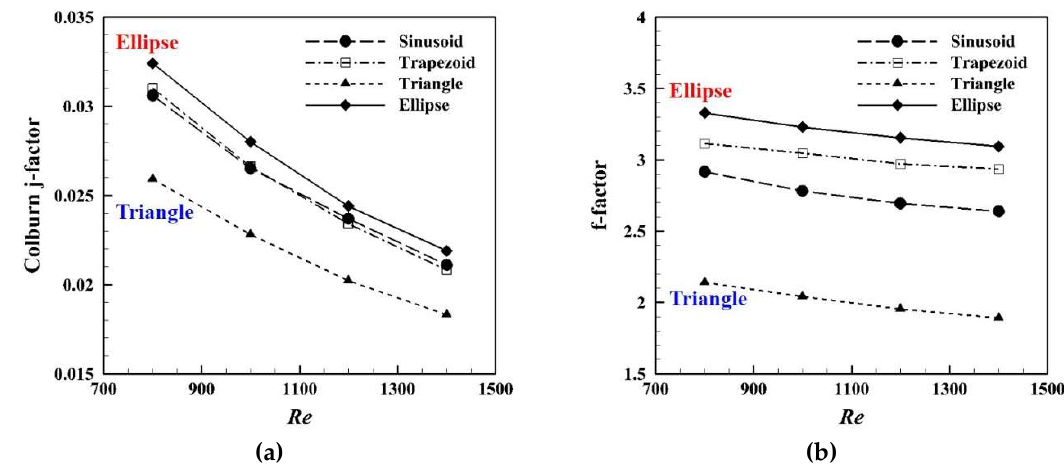
Figure 12. ( a ) Colburn j -factor and ( b ) friction factor for each corrugation profile according to the Reynolds number.